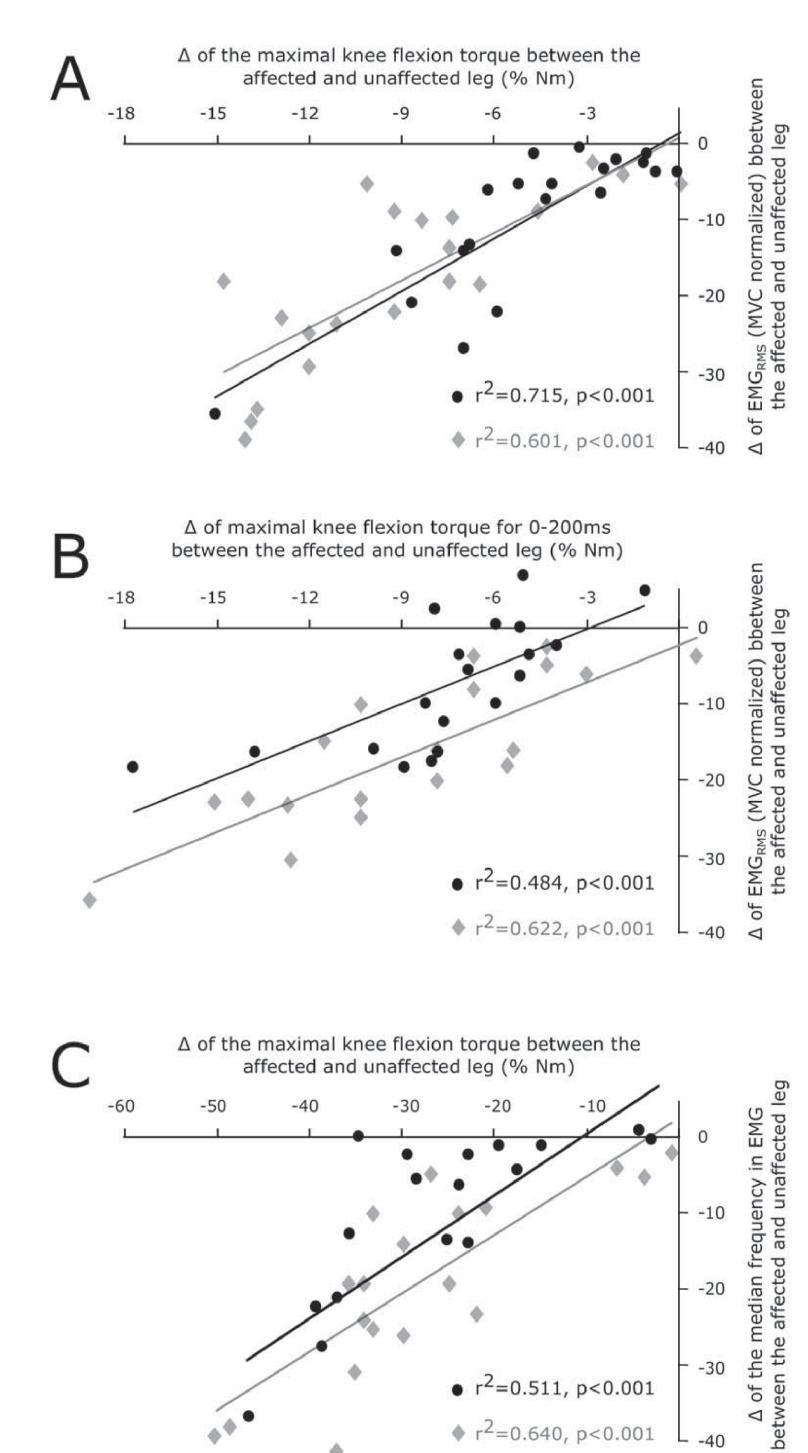
Fig 5. Scatter plots with regression lines. They are illustrated for differences ( Δ ) between the unaffected leg and the affected leg with MSI history in the biceps femoris long head (BF) muscles of the MSI group (n = 20) for the slow (30˚/ s, black) and fast (120˚/s, grey) eccentric contraction. A illustrates the plot for maximal torque and BF EMG RMS (normalized to MVC) for the entire range of motion. B illustrates maximal torque and BF EMG RMS for the interval 0–200ms after contraction onset. Graph C illustrates the plot for maximal torque and the corresponding the medium frequency. Regressions A–C are significantly positive.